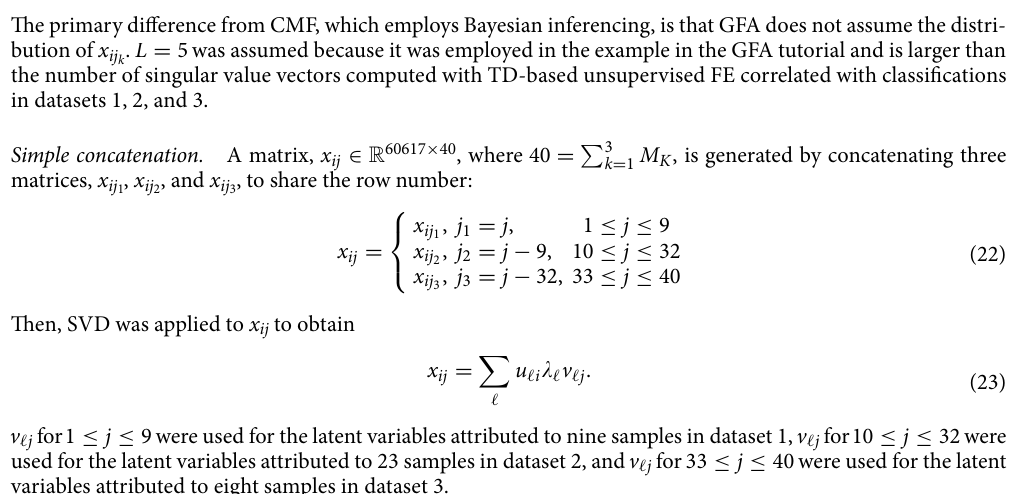
Classification. Evaluation of classification performances were tested via linear discriminant analysis (LDA) using + lda+ function in MASS package in R 21 . Labels are treated as factors and prior probabilities of individual labels are set to be equal. Leave one out cross validation was employed with setting “CV=T”